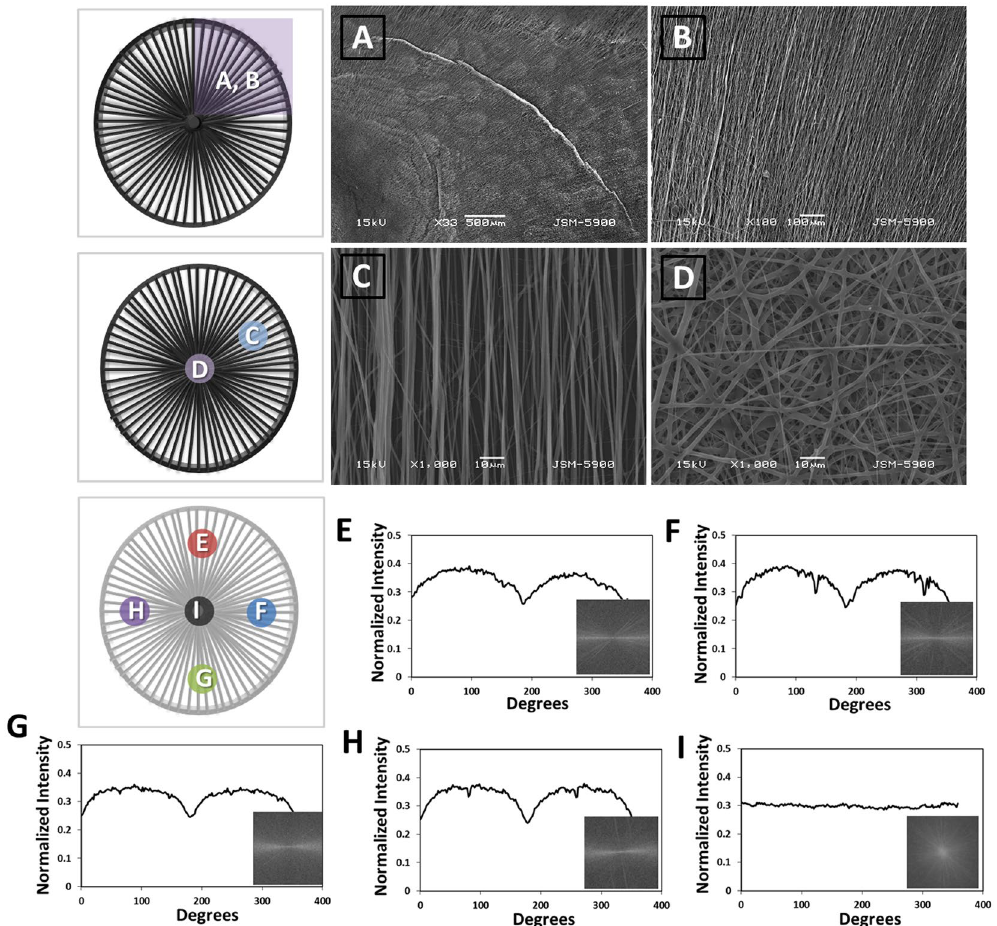
Figure 4. ( A , B ) SEM images of radially oriented aligned nanofibers on the ( A ) and ( B ) parts shown in the illustration. ( C ) SEM image of aligned nanofibers on the C part shown in the illustration. ( D ) SEM image of random nanofibers on the D part shown in the illustration. ( E – I ) FFT output images for the nanofibers with pixel intensity plots against the angle of acquisition of each part of the letter, shown on the 3D radially aligned nanofibrous